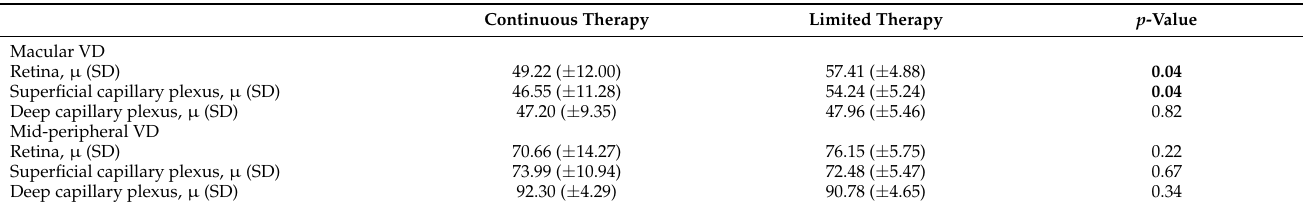
Table 3. Comparison of vessel density among patients receiving continuous vs. limited anti-VEGF therapy for